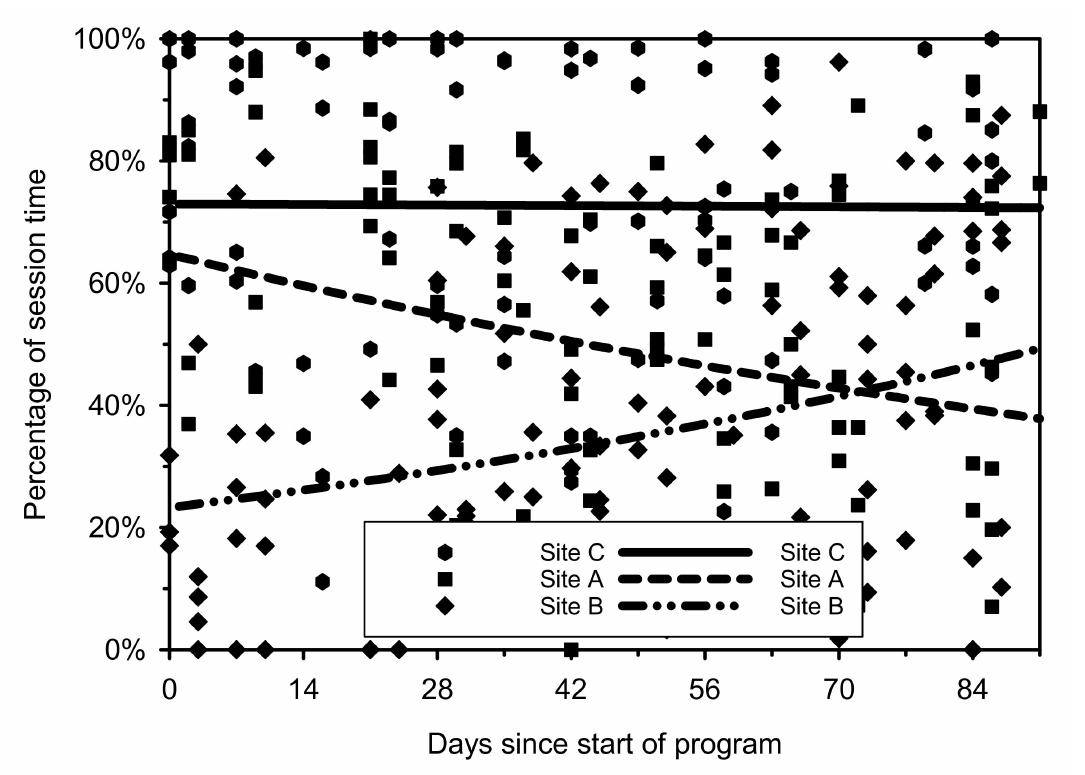
Figure 1. Scattergram of percentage of session time spent in or above participant target heart rate zone across time by site. The fitted regression lines are derived from a multivariable Poisson model.